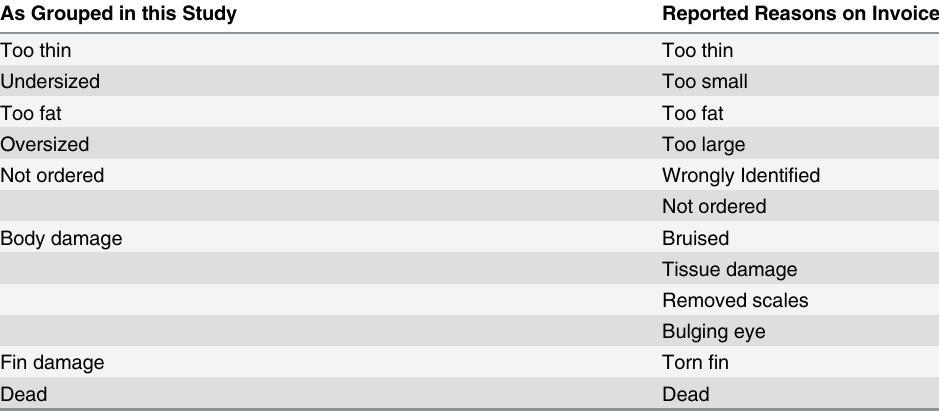
Table 1. Reasons given for fish rejections and the grouping terms used in this study. As Grouped in this Study Reported Reasons on